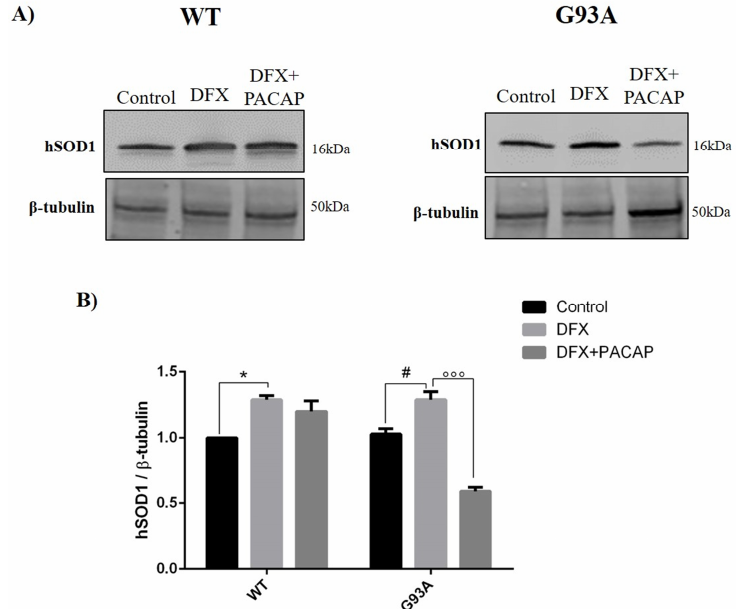
Figure 3. PACAP interferes with the hSOD1 expression in the WT and G93A cells under hypoxia. ( A ) Representative immunoblots of the signals detected for the hSOD1 expression on the WT and G93A cell homogenates cultured for 24 h in desferrioxamine mesylate salt (DFX) alone or in combination with PACAP (DFX + PACAP). ( B ) The bar graph shows the results of three independent experiments. Relative band density was quantified by using the ImageJ software and the protein levels are normalized to β-tubulin, which was used as a loading control. Data are expressed as a mean ± SEM of values normalized to the WT/control data set to 1.0 ( * p < 0.05 vs. WT control, # p < 0.05 G93A control and °°° p < 0.001 vs. G93A DFX, as determined by a one-way ANOVA followed by Tukey's post-hoc test).